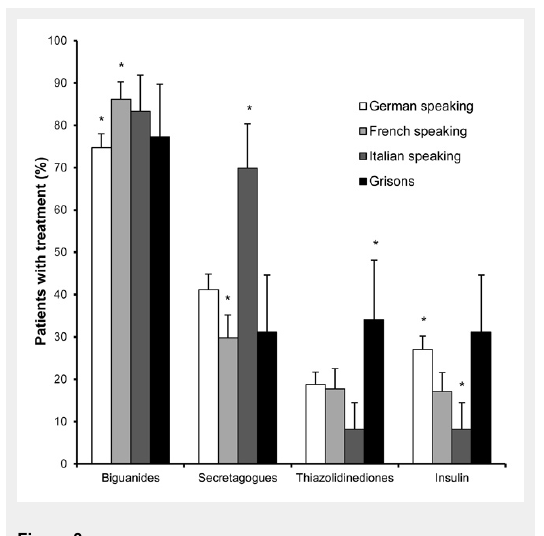
Diabetes therapy with different anti-hyperglycaemic drugs at the time of the survey in different cultural regions of Switzerland. * indicates regions in which therapy differed from the other regions, p <0.01.